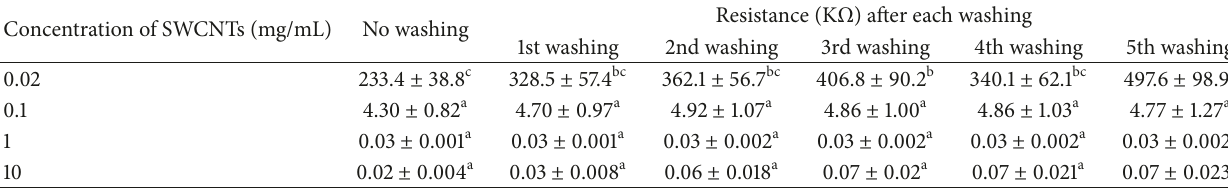
Table 1: Resistance of SWCNT immobilized onto sensor platform. Concentration of SWCNTs (mg/mL)